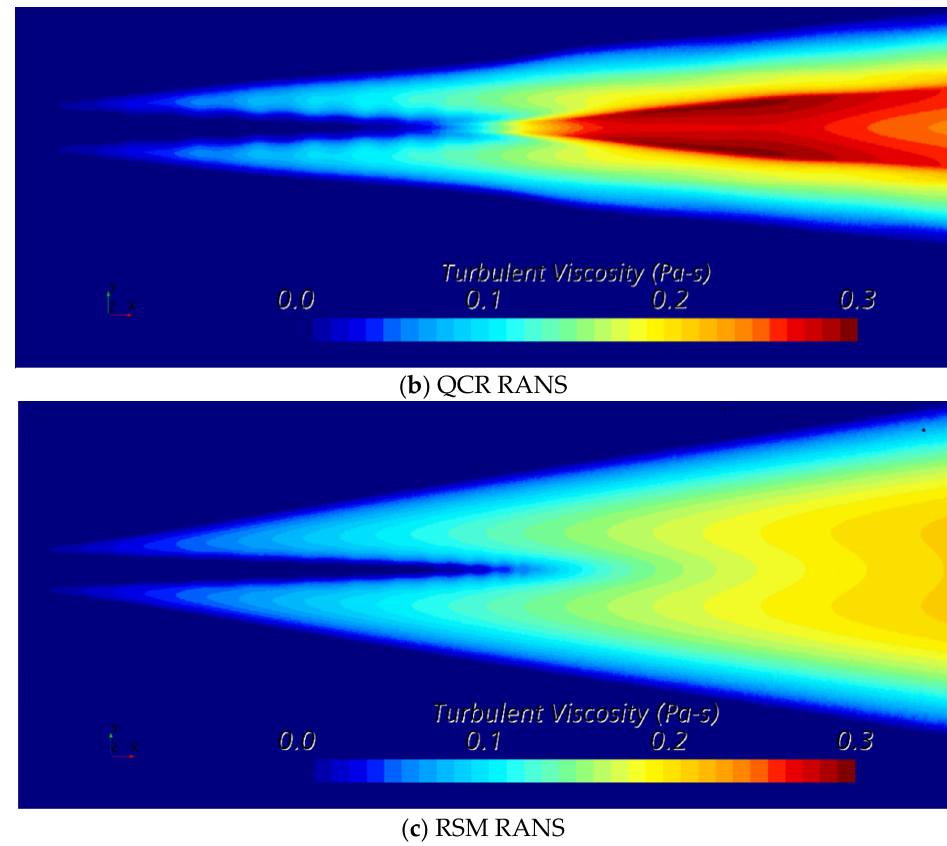
Figure 15. Contours of eddy viscosity downstream of the nozzle exit.